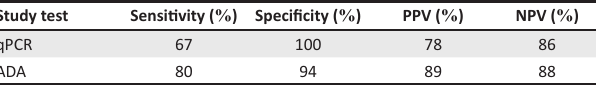
TABLE 2: Operating characteristics of real-time polymerase chain reaction and adenosine deaminase assay in comparison with the gold standard culture in pleural tuberculosis, Pretoria, South Africa,